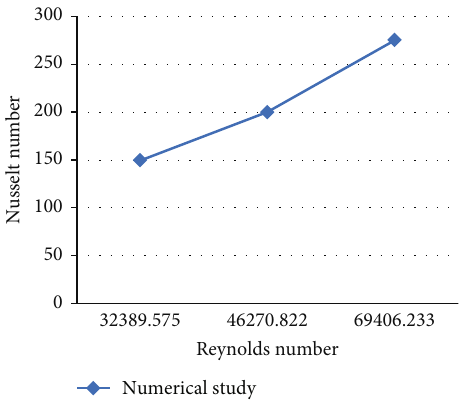
Figure 9: Variation of Nusselt number with Reynolds number with 1%